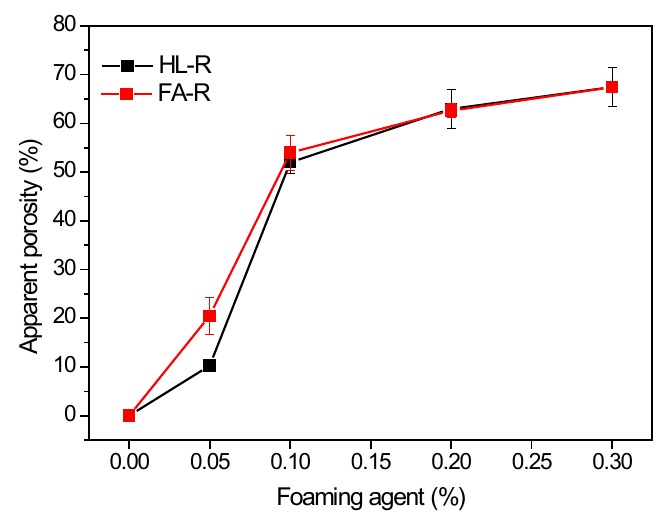
Figure 9. Apparent porosity of HL-R and FA-R samples as a function of the foaming agent amount.